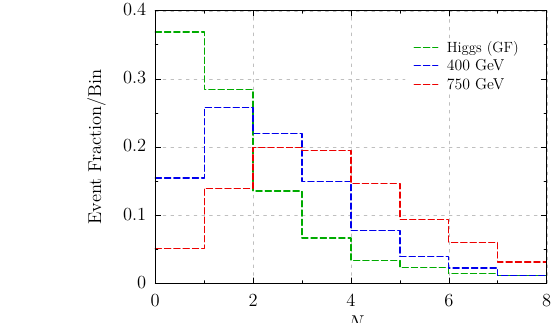
table 2. Our objects have been reconstructed at truth-level and corrected with o(cid:15)ine en-